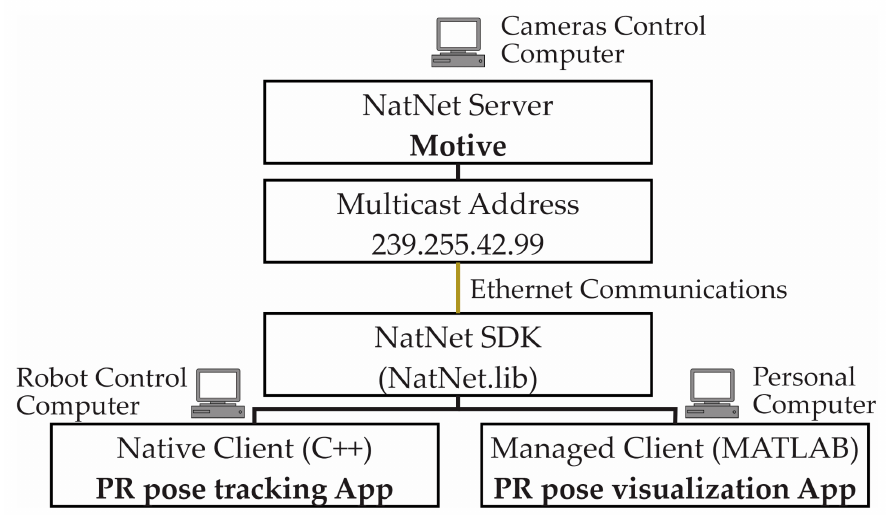
Figure 5. Software architecture of the OptiTrack